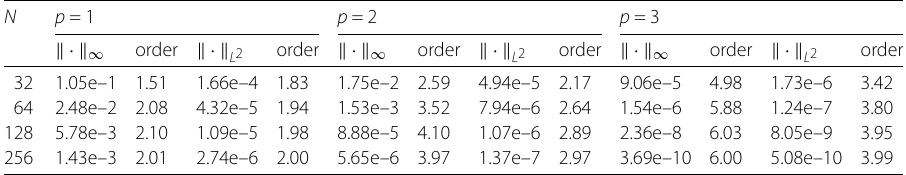
Table 3 Shishkin mesh, τ (cid:2) = min { 0.5,– (cid:2) ( p + 1)ln (cid:2) } , (cid:2) = 10 –6